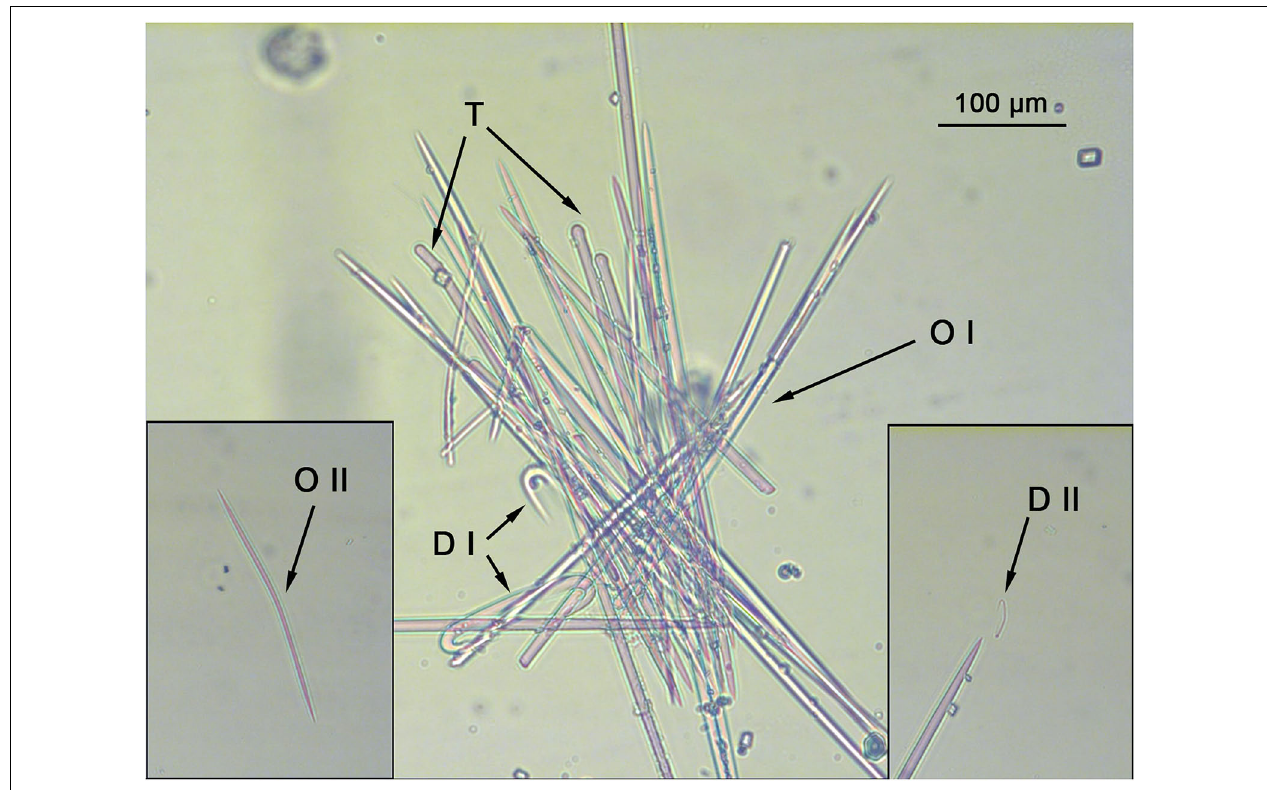
FIGURE 5 | Hamacantha ( Hamacantha ) hortae sp. nov. spicular set. The skeleton is formed by loose tracts of tylostyles (T) and oxeas in two size categories (O I and O II), with diancistras in two size categories (D I and D II) scattered around. Scale bar, 100 µ m.